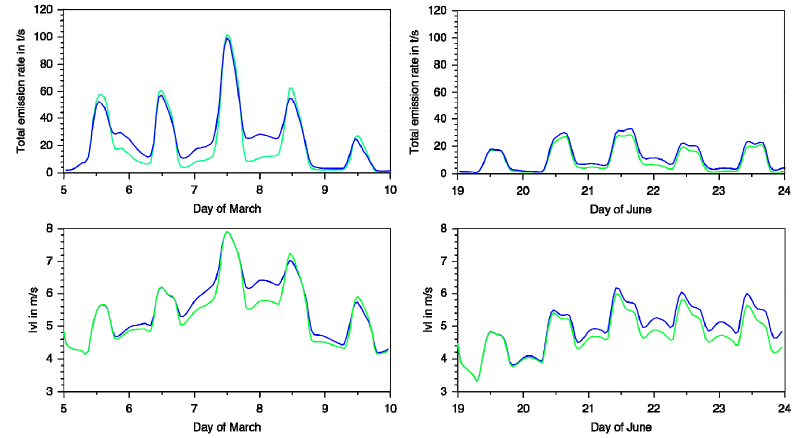
Fig. 12. Total emission rate of mineral dust particles in t / s (top) and the averaged absolute value of wind velocity at 10m above surface (bottom) for the area 18 ◦ W–20 ◦ E, 12 ◦ N–35 ◦ N calculated by run F (blue) and CTRL (green) for the dust events in March 2006 (left) and June 2007